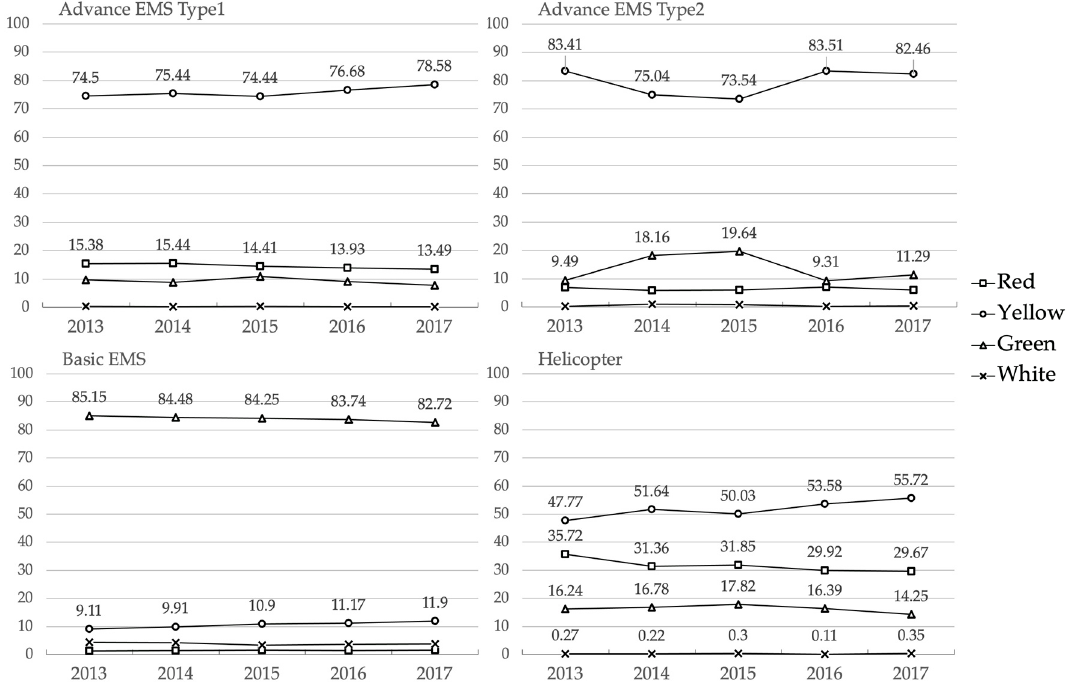
Figure 2. Proportional frequencies (%) of rescue completion (RC) at a hospital emergency department (ED) by Emergency Medical Services (EMS) criticality codes (Red, Yellow, Green, White) for type of